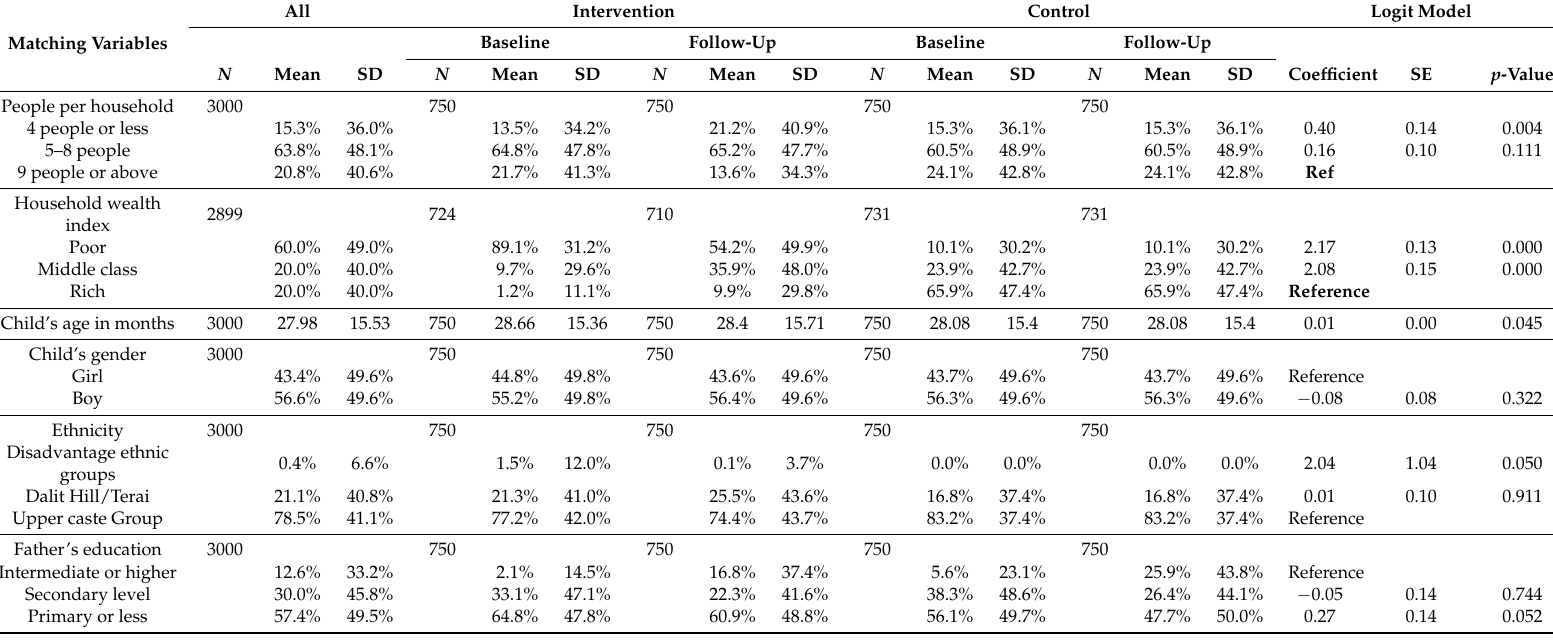
Table 2. Summary statistics of the matching variables and estimates of logit regression models for stage 1 of propensity score